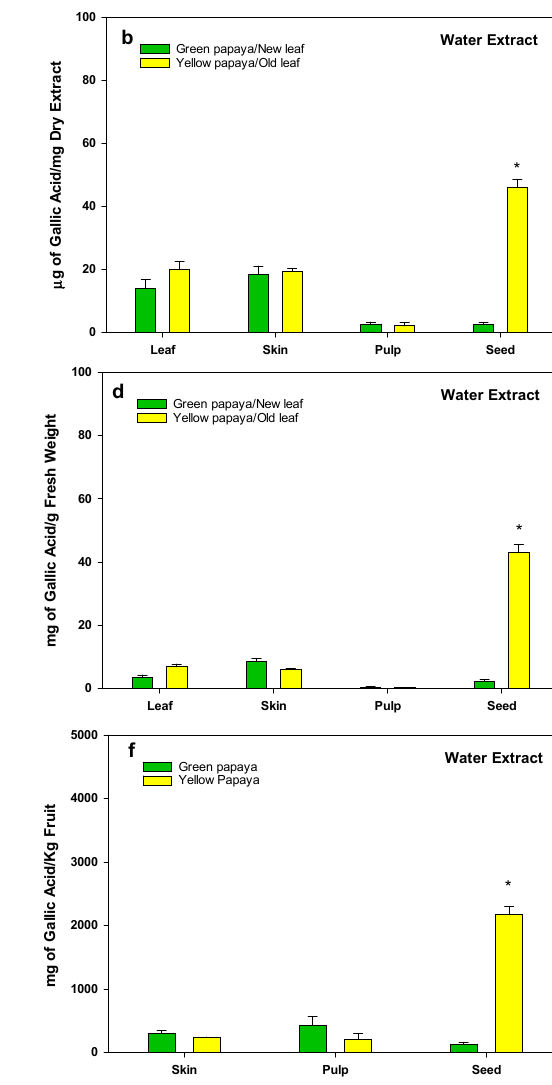
Figure 1. Total polyphenols in green and yellow papaya. Total polyphenols (TPC) were measured